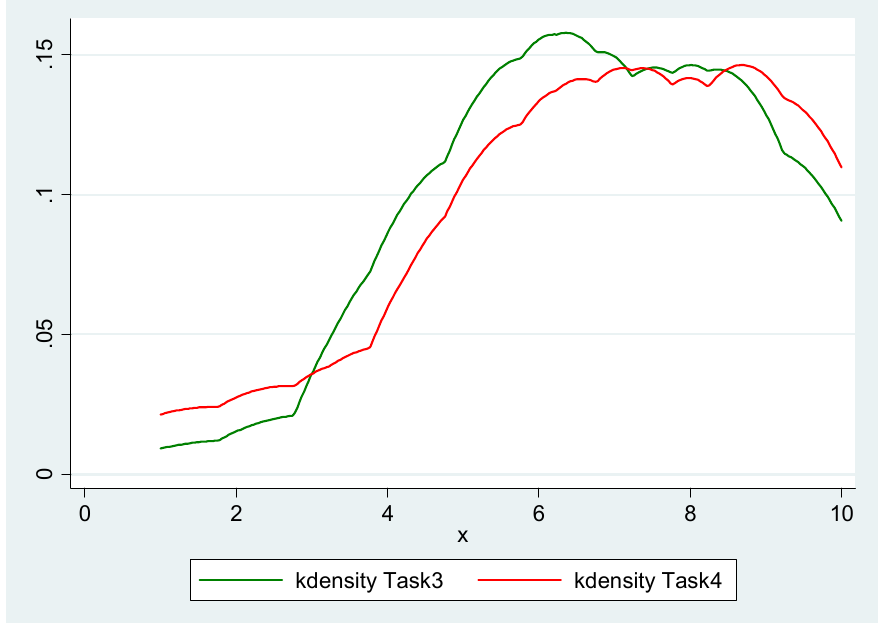
Figure A7. Kernel densities of the choice numbers (in Bins. tasks). Selected by the subjects, which represent the distributions of the degrees of risk aversion.